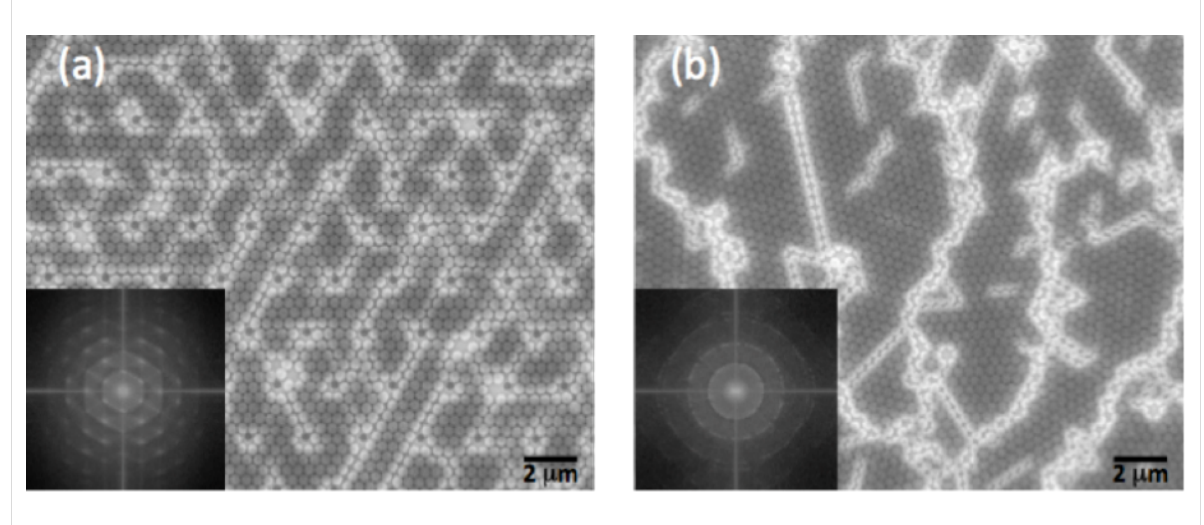
Figure 2: SEM images showing a comparison of (a) structures with a template (topology assisted self-organization) and (b) structures fabricated in the absence of a template (simple self-organization).